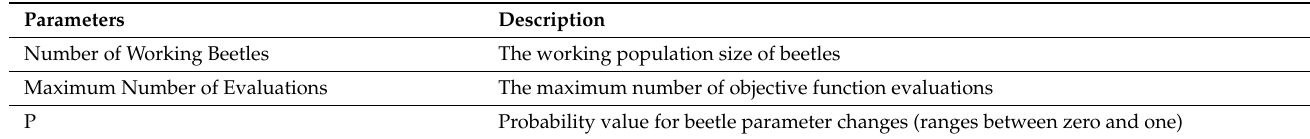
Table 10. pbBAS algorithm parameters